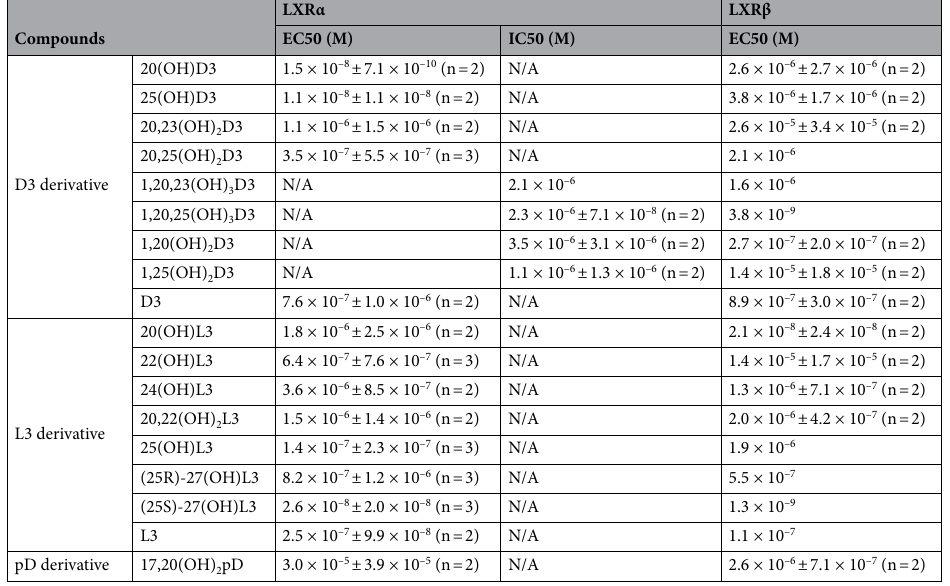
Table 1. Characteristics of binding of L3 and D3 derivatives to the LBD of LXRα and